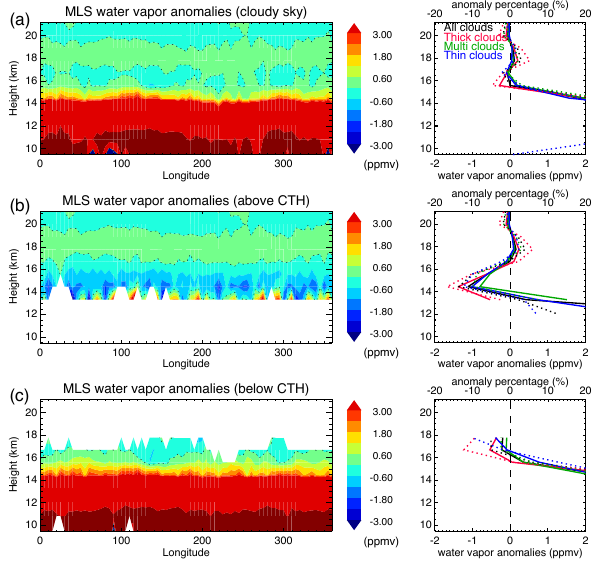
Fig. 6. The same as figure 4 except water vapor anomalies. Dot-lines in right figures indicate relative change in percentage with height.